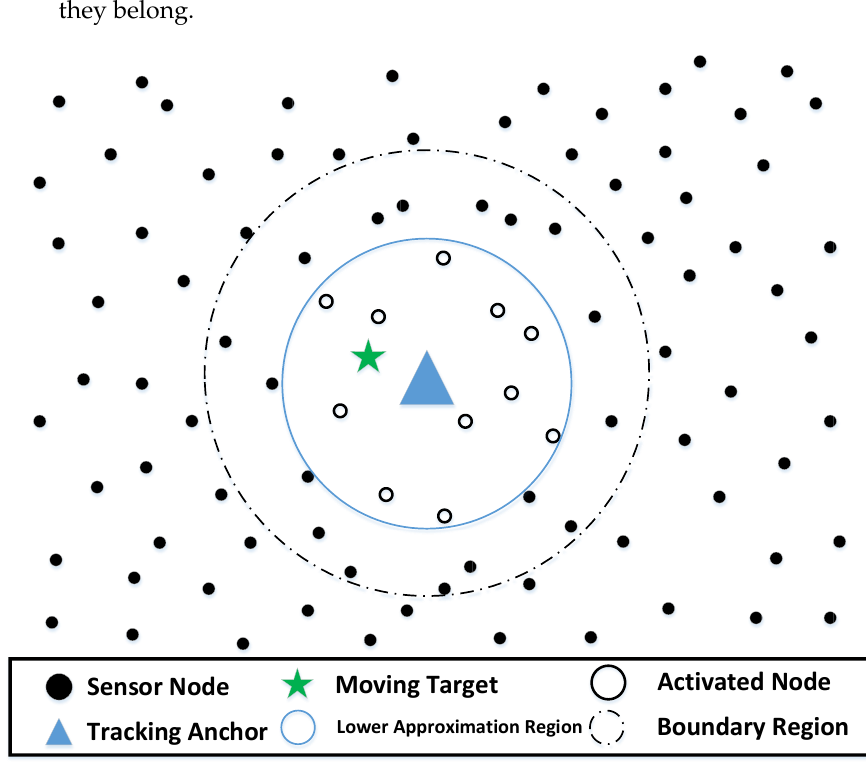
Figure 5. Sensor Activation Scenario (1).